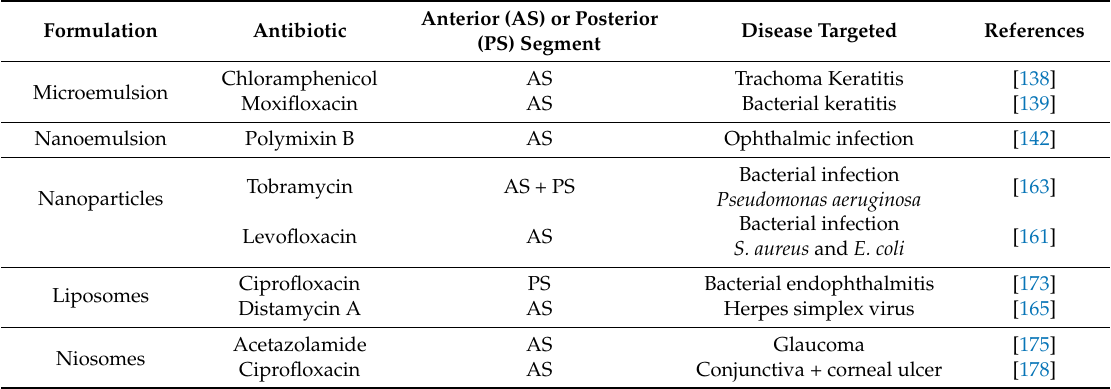
Table 2. Example of colloidal system for ocular drug delivery of